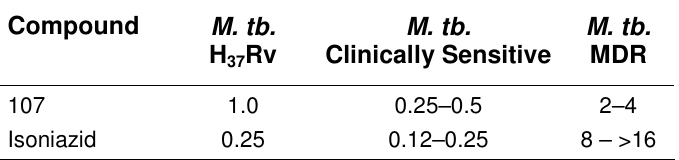
Comparative MIC Values ( µ g/ml) between Compound 107 and Isoniazid